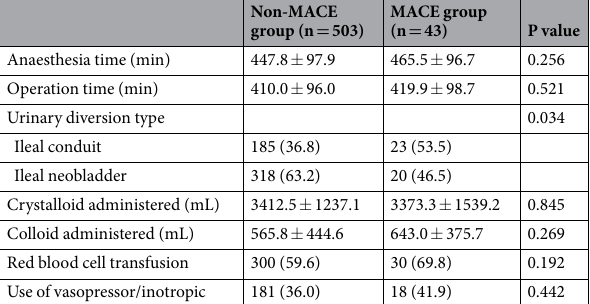
Table 2. Intraoperative data of 546 patients who underwent radical cystectomy. Data are expressed as mean ± standard deviation or number of patients (%). MACE = major adverse cardiac